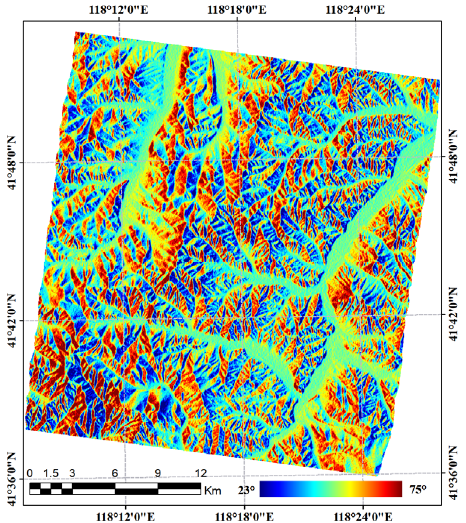
Figure 7. Local incidence angle ( θ loc ).